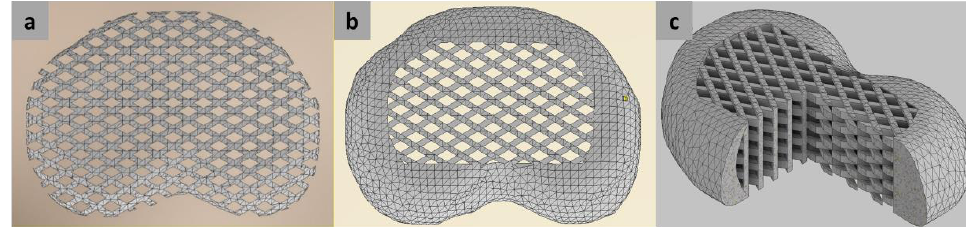
Figure 2. Top view of the FLC-MTDR ( a ) and ABC-MTDR ( b ). ( c ) The cross-section view of the ABC-MTDR. All 3D models were based on the reconstructed L1L2 IVD and modified using an Autodesk Inventor software.